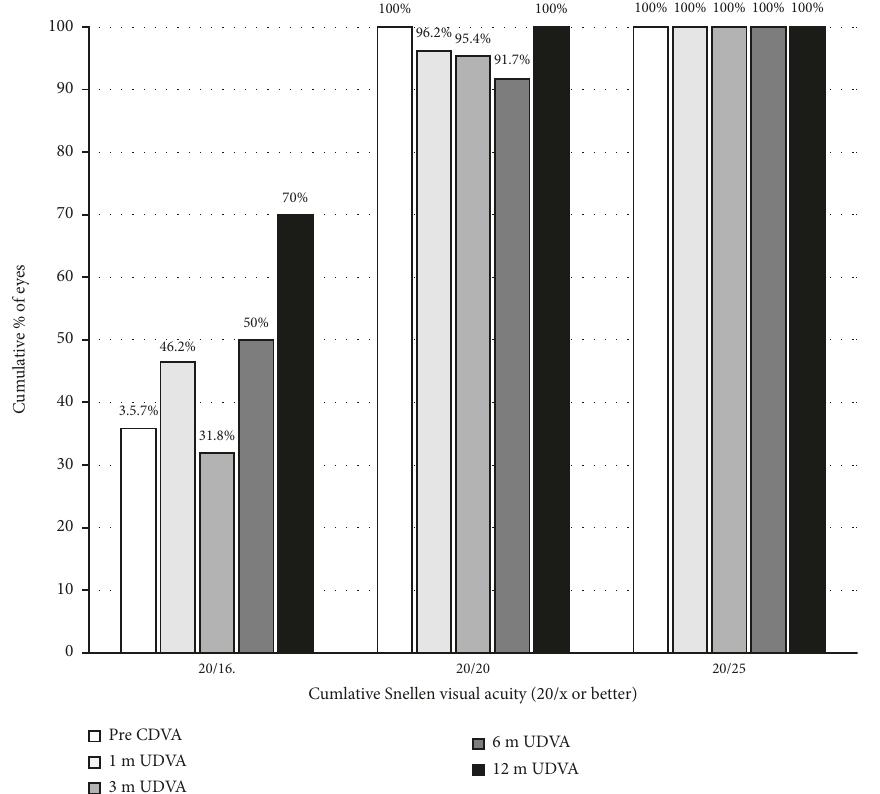
Figure 1: The cumulative percentage of the eyes attaining specified cumulative levels of postoperative uncorrected distance visual acuity (UDVA).